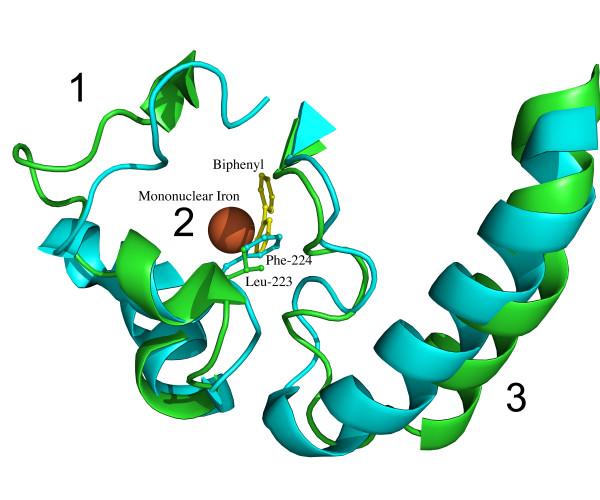
Comparison of the active site entrances of BPDO-OB1 and NDO-O9816-4. Cartoon diagrams of the active site entrances for BPDO-OB1 (green) and NDO-O9816-4 (cyan). Multiple differences in the loop structure lead to a larger opening to the active site in BPDO-OB1. At position 1, the loop structure is pushed away from the entrance, compared to NDO-O9816-4. Position 2 shows the increased bulk of the Phe-224 side chain in the entrance opening, compared to the side chain of Leu-223 of BPDO-OB1. Finally, postion 3 shows a shift of the helix, which pulls the active site entrance open, compared to NDO-O9816-4. Biphenyl bound in the active site is shown in yellow and the mononuclear iron is shown as a rust-colored sphere. See Additional file 1, which shows these structures rotating in three dimensional space.